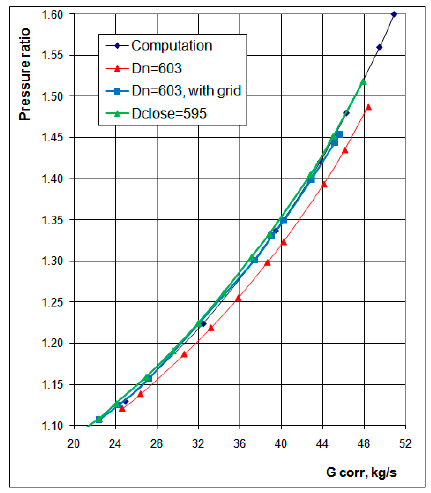
Figure 20. Total pressure ratio as a function of corrected air flow of the fan.